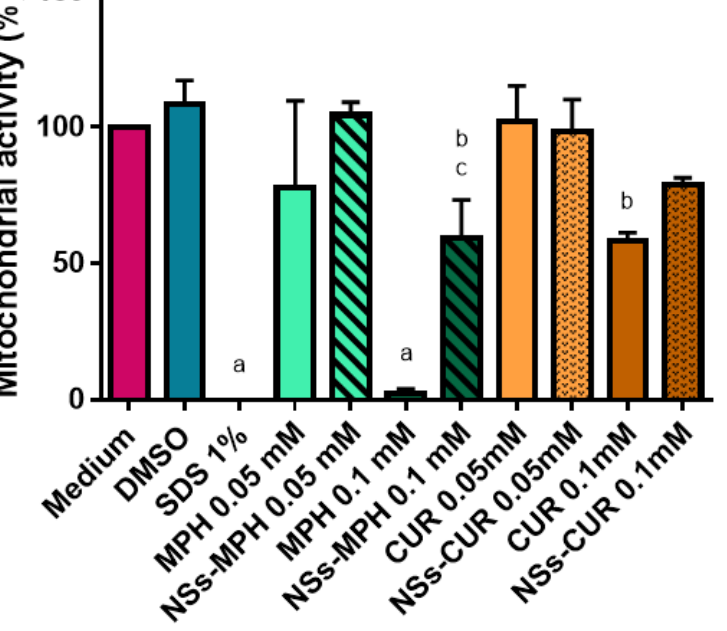
Figure 17. Effects of MPH, CUR, NSs–MPH and NSs–CUR on mitochondrial activity, determined with the MTS assay. The results are expressed as percentages compared with untreated cells (medium) and represent the mean ± SD of n = 3 (a = **** p < 0.0001, b = * p < 0.05). c represents the comparison between MPH 0.1 mM and NSs–MPH 0.1 mM (c = *** p < 0.001).